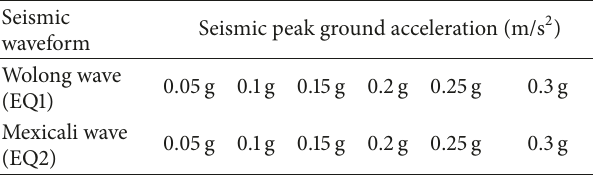
Table 1: Seismic waveforms employed in testing and their peak ground acceleration